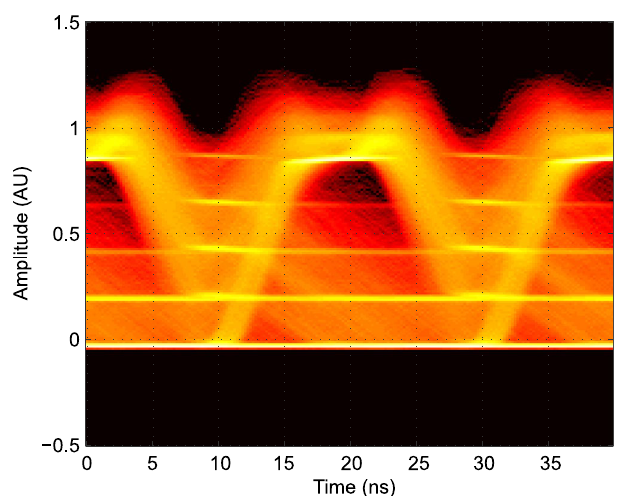
Figure 9. Eye-diagram for analog processing of the 4 quencher circuits (QC) output data for 50 Mbit/s RZ at an optical power of 7.5 nW. The filtered signal of the sum of the 4 latch outputs from Matlab was used to construct the eye-diagram. The clock from the bit pattern generator, which generated the Data signal was used as trigger to overlay 90.000